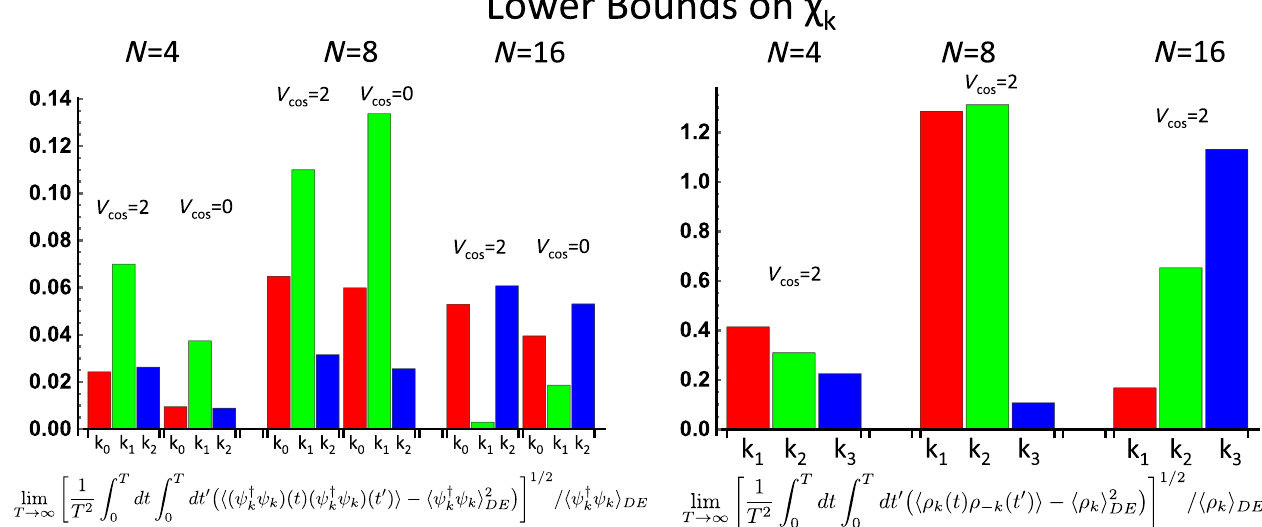
FIG. 9. The lower bounds on χ k due to the effective charge Q for correlators involving the MDF and the density operators. Left-hand panel: We plot the lower bound on MDF correlations for two different quenches in a c ¼ 10 gas. In the first (the left sets of bars), we 0 . 26 E quench into a cosine potential V cos ð 2 π x=L Þ of amplitude V F . In the second (the right set of bars), we quench into a flat cos cos ¼ 0 , where the post-quench Hamiltonian is then integrable. We present χ potential, i.e., V k for three different system sizes cos ¼ N ¼ L ¼ 4 ; 8 , and 16 and three different values of k , k 2 π n=L , n ¼ 0 ; 1 , and 2. The initial state of the quench is given by the ground n ¼ state of a gas in a parabolic potential of strength ω ¼ 2 . 4 =N . Right-hand panel: We similarly plot the lower bound on density 2 , as χ correlations. Here, we only consider the case of quenching into V k for the density operator is identically zero in the absence cos ¼ of the breaking of translational invariance. We again compute the lower bound at three different system sizes and three different wave vectors k 1 ; k 2 , and k 3 . In both cases, we see no obvious dependence on system size. We believe that the fluctuations seen between different system sizes results from the particular construction of Q at any given system size. We construct Q to minimize time fluctuations of a particular initial condition rather than construct it to maximize its overlap with a particular observable as was done in Ref.